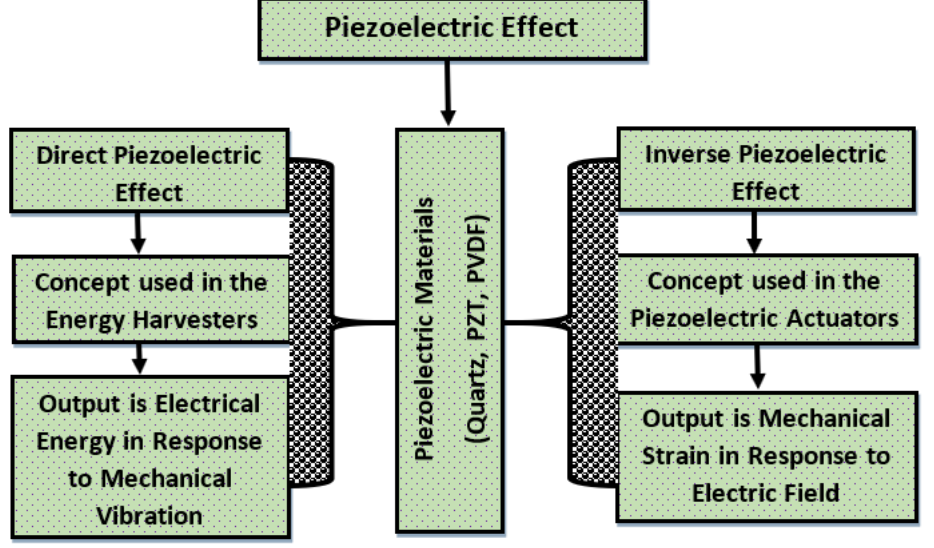
Figure 1. Categories of the piezoelectric effect.